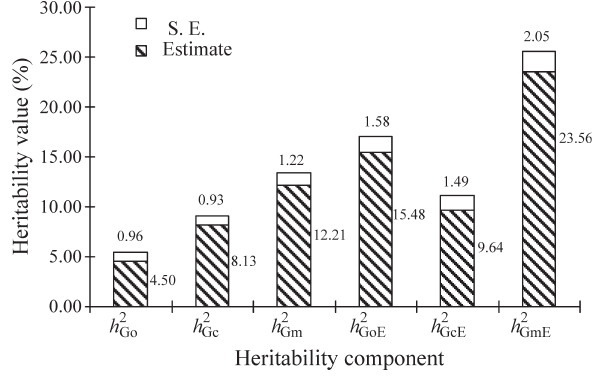
Figure 3 - Estimates of percentage oil content heritability components for oilseed rape. Values on the upper and right side of the columns are stan- dard error (SE) and variance component estimates. All estimates were sig- nificant at p = 0.01.